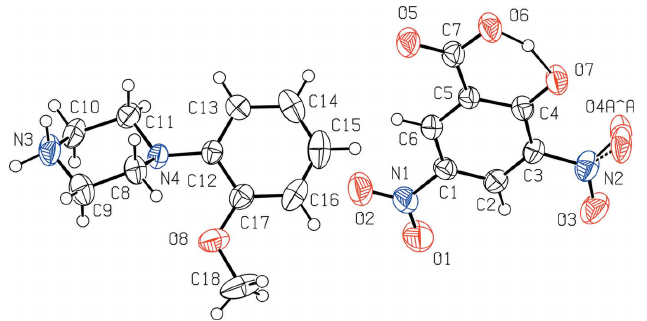
Figure 1 The molecular structure of the title molecular salt, (I), showing the atom- labelling scheme. Displacement ellipsoids are drawn at the 50% probability